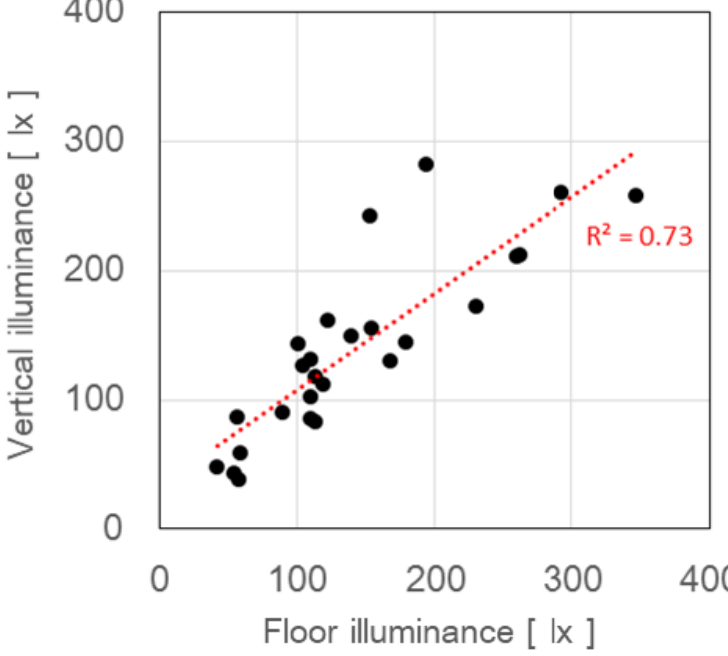
Figure 7. Regression line of the floor and vertical illuminances.